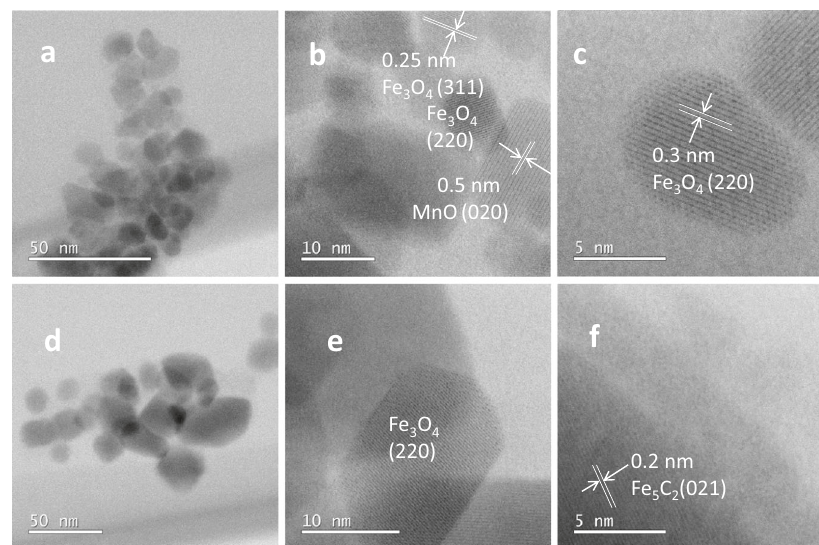
Fig. 4 STEM-BF images of the Fe – Mn – K at different nanoscales. a – c The Fe – Mn – K catalyst precursor; d – f the used Fe – Mn – K catalyst.